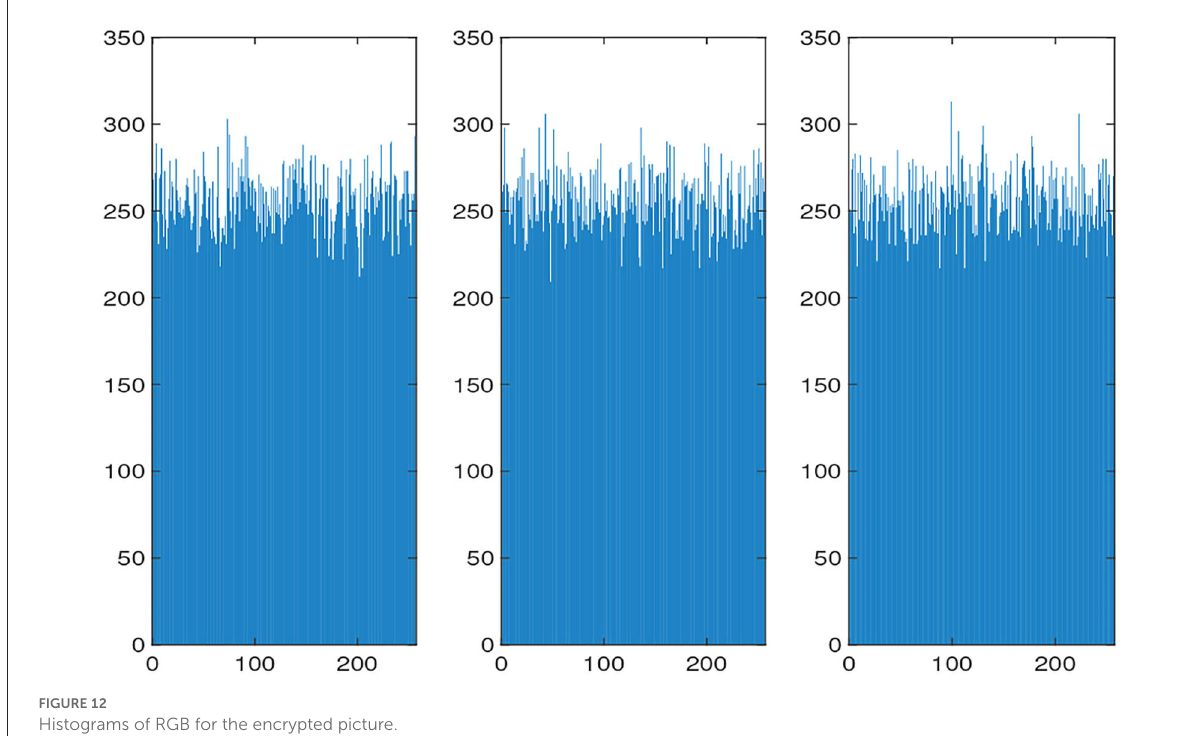
FIGURE12 Histograms of RGB for the encrypted picture.